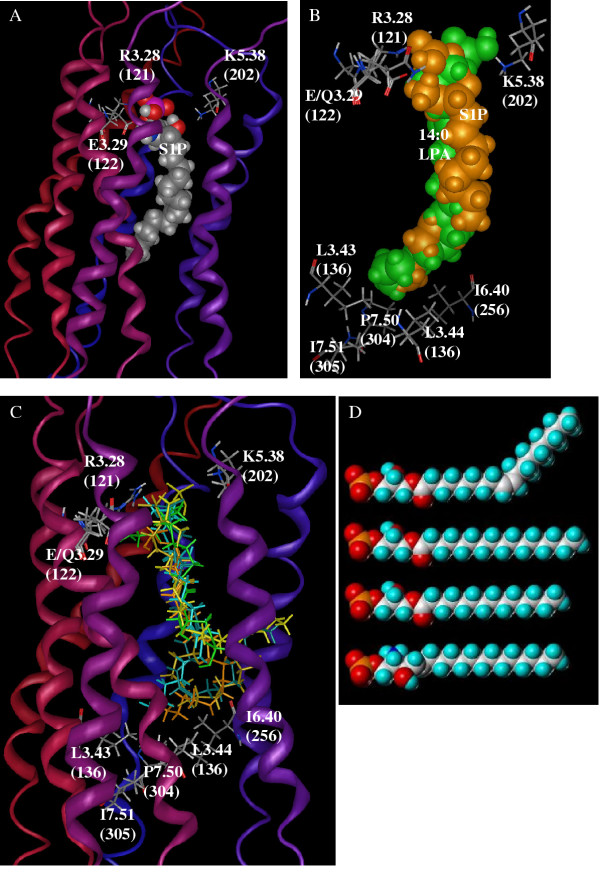
Computational models of wild type S1P4 and its E3.29(122)Q mutant with S1P and LPA species. Computational models of the complexes between the wild type S1P4 or its E3.29(122)Q mutant with S1P or various LPA species generated by Autodock 3.0 and minimised using the MMFF94 forcefield in the MOE program. Complexes in each panel are shown from the same viewpoint with the extracellular end of the receptors oriented to the top of the figure. Standard element color codes are used with grey, white red, blue and magenta representing carbon, hydrogen, oxygen, nitrogen and phosphorous. Ribbons are shaded from red at the amino-terminus to blue at the carboxy-terminus. (A) Model of the complex between S1P (spacefilling) and the wild type S1P4 receptor. Residues in the receptor involved in ion pairs with S1P are shown as stick models and labelled. (B) Superimposition of the wild type S1P4 complex with S1P (orange) and the E3.29(122)Q S1P4 mutant complex with 14:0 LPA (green). For clarity, the only position at which the modelled amino acid position is shown for both receptor models is 3.29(122). Other residues had very similar optimised positions in the two model structures. (C) Superimposition of wild type S1P4 complexes with 18:1 LPA (cyan), 16:0 LPA (yellow) and 14:0 LPA (green) on E3.29(122)Q mutant complexes with 18:1 LPA (blue-green), 16:0 LPA (gold) and S1P (orange). For clarity, the only position at which modelled amino acid position is shown for both the wild type and mutant receptor models is 3.29(122). Other residues had very similar optimised positions in all model structures. (D) Space-filling models which represent the minimised extended conformation of each structure were constructed using SYBYL 6.9 software (Tripos Inc., St. Louis, MO., U.S.A.). The distance between phosphorus and terminal carbon atoms was predicted for each structure listed from top to bottom: 18:1 LPA, 27.0 Å; 16:0 LPA, 26.7 Å; 14:0 LPA, 24.2 Å; S1P, 24.0 Å.